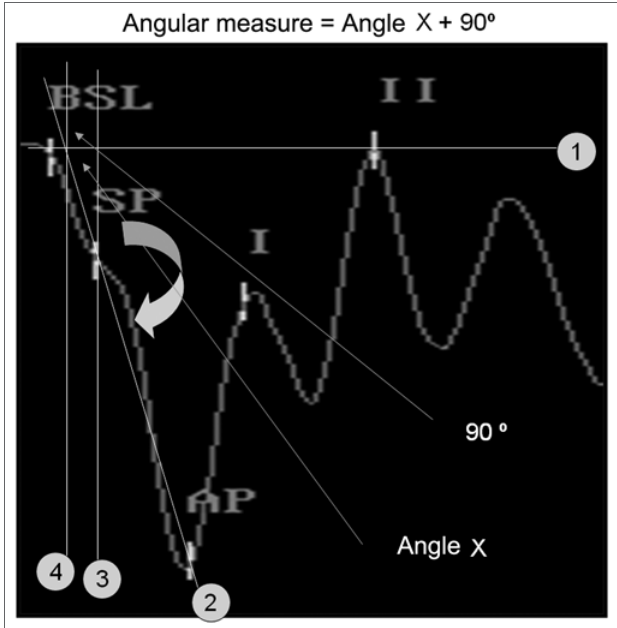
Figure 2. Steps to obtain the graphic method in order to measure the angle: -Place line 1 on the baseline, -Place line 2 between SP and AP and extend it all the way to the baseline, -Place line 3, which passes through the SP and is perpendicular to the baseline, -We then obtain the Angle which will be measured. -Place line 4 parallel to line 3 perpendicular to the baseline and on the point where line 2 meets the baseline, -Here we have the X angle -The measure corresponds to the X angle plus 90° -The X angle is calculated in the formula with the x and y coordinate points in the plane, latency and amplitude in reference of the baseline.